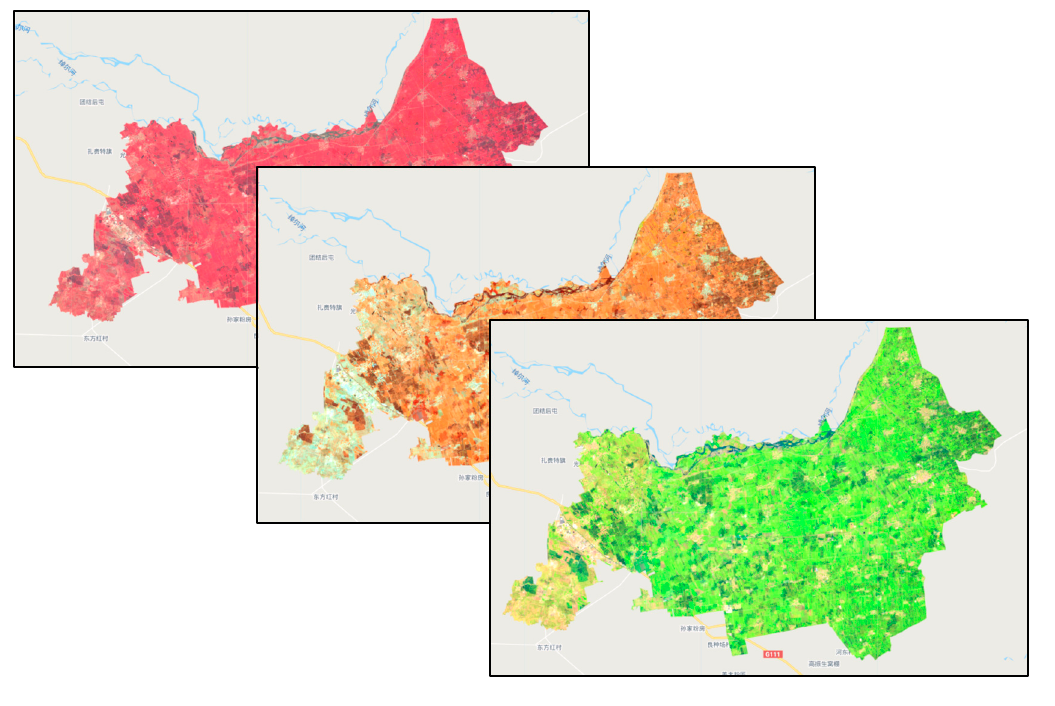
Figure 2. False color composite images.